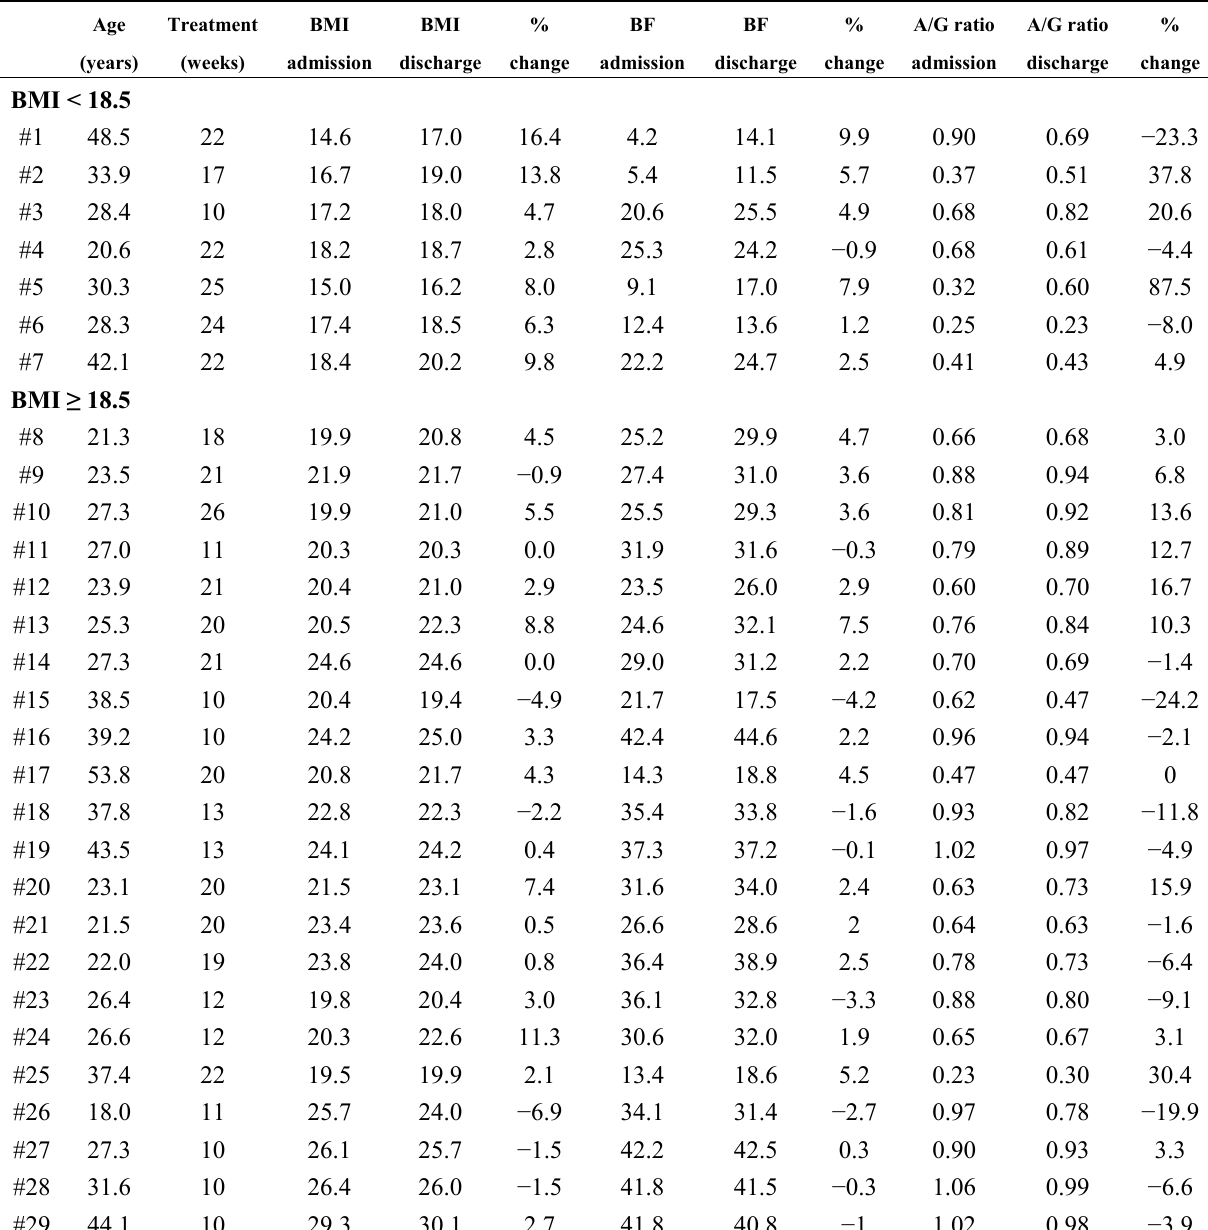
Table 3. Changes in BMI, body fat percentage and android/gynoid ratio in each patient during the treatment